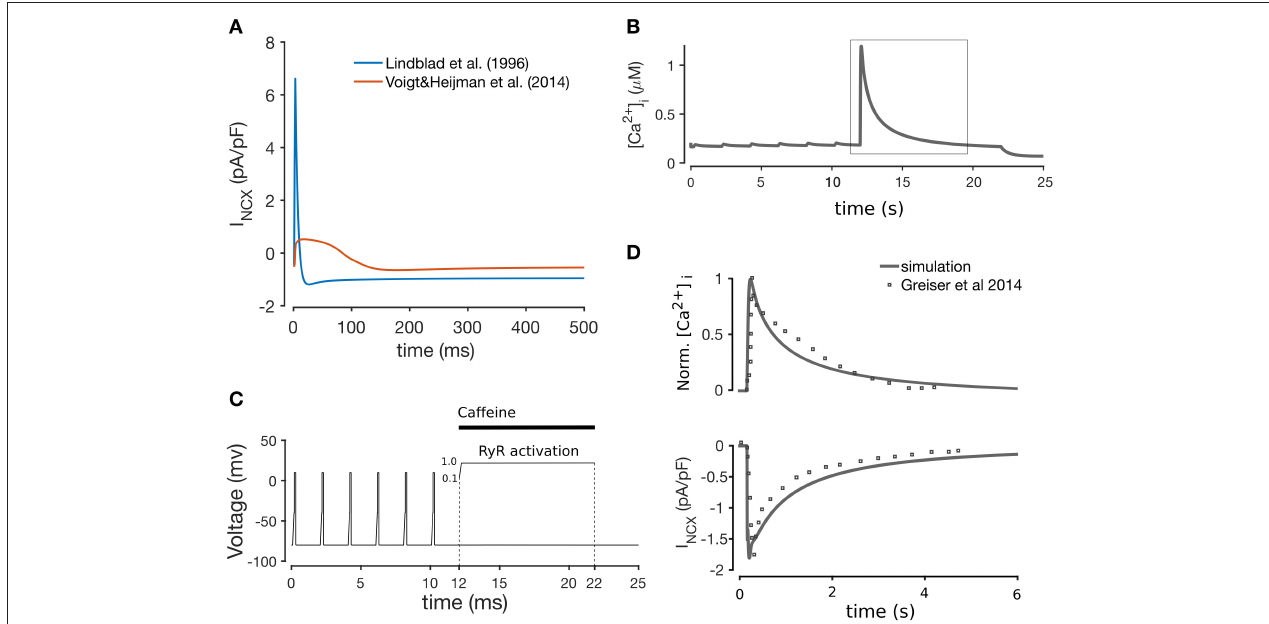
FIGURE 2 | (A) Comparison between the Lindblad et al. (1996) and Voigt et al. (2014) models of the Na + -K + exchanger, showing that the latter is closer to the I NCX shape observed experimentally (Bers, 2002). Simulation of caffeine-induced Ca 2 + release (B) using the voltage clamp protocol shown in (C) , whereby application of caffeine is simulated through the instant opening of the RyRs for 10s with subsequent closing. (D) Comparison of I NCX and normalized CaT with experimental data from Greiser et al. (2014), after pacing at 0.5Hz for 12s, and a 10s quiescent period.